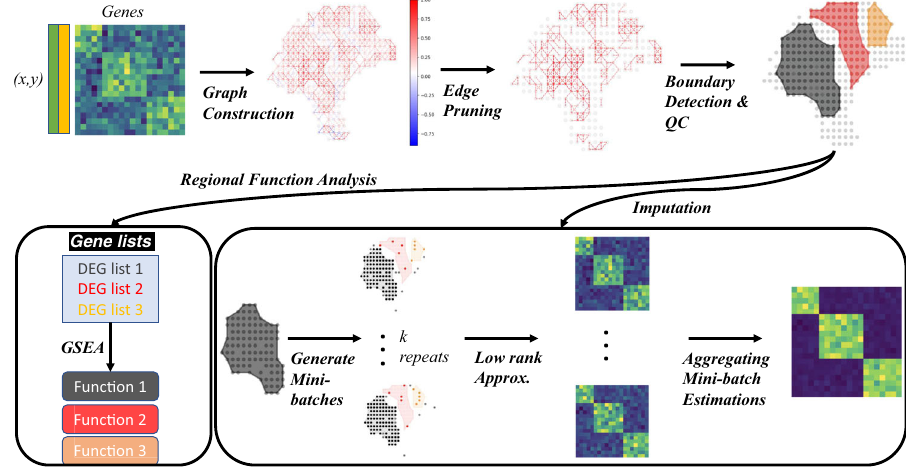
Fig. 1 | The MIST pipeline. MIST constructs a graph using the spatial gene expression matrix, removes edges with low weights, and draws the boundaries to detect molecular regions within the ST sample. Next, MIST enables two function- alities. The regional function analysis module detects regional activated gene lists